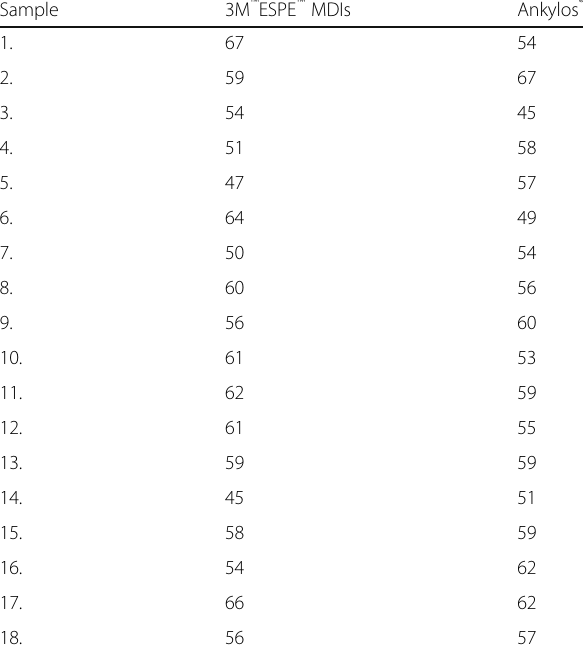
Table 1 Comparison of % BIC in both groups Sample